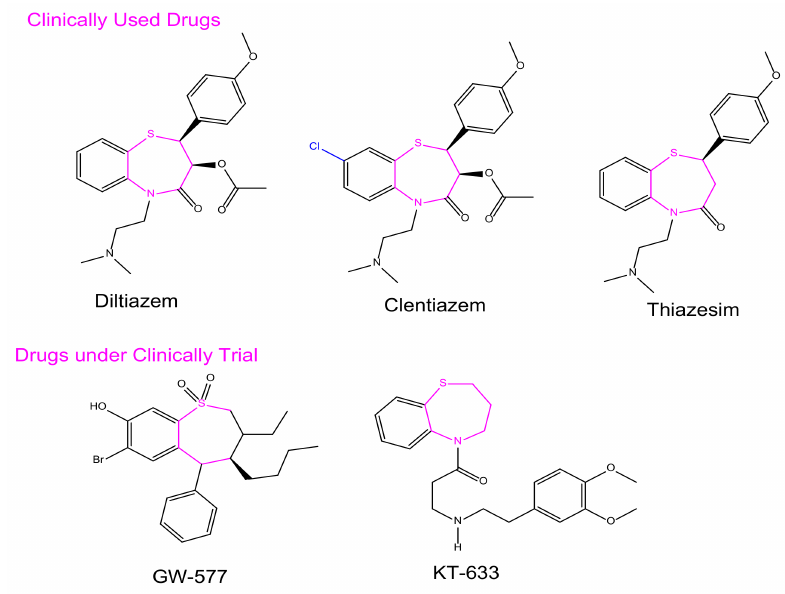
Figure 1. Representative BTZ derivatives either in clinical use or currently undergoing clinical